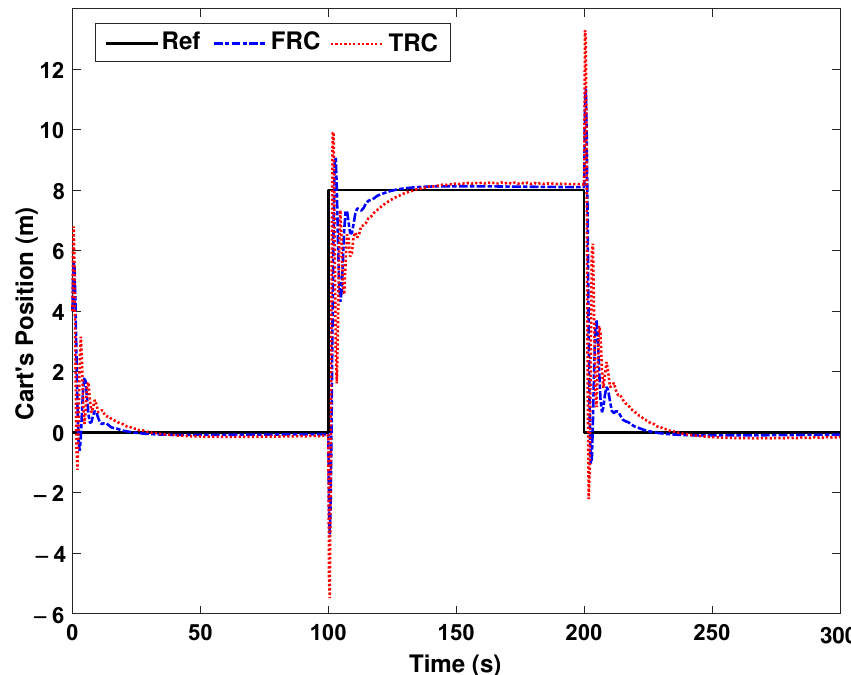
Figure 8. Position control of cart by FRC and